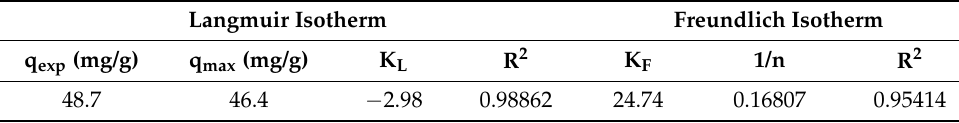
Table 3. Parameters for Langmuir and Freundlich adsorption isotherms.